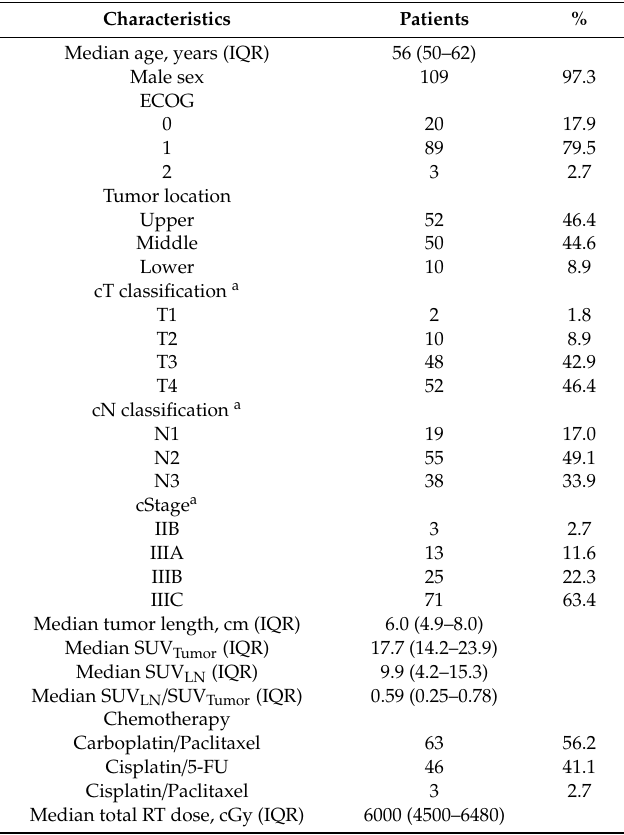
Figure 1. Flowchart of treatment characteristics of eligible patients through the study. cN + M0 ESCC: Clinically node-positive nonmetastatic esophageal squamous cell carcinoma; CRT: Chemoradiotherapy; dCRT: Definitive chemoradiotherapy; RT: Radiotherapy. *This included the five patients who did not undergo consolidative CRT due to the detection of interval metastasis. Table 1. Baseline characteristics of patients who underwent positron emission tomography / computed tomography before dCRT for esophageal squamous cell